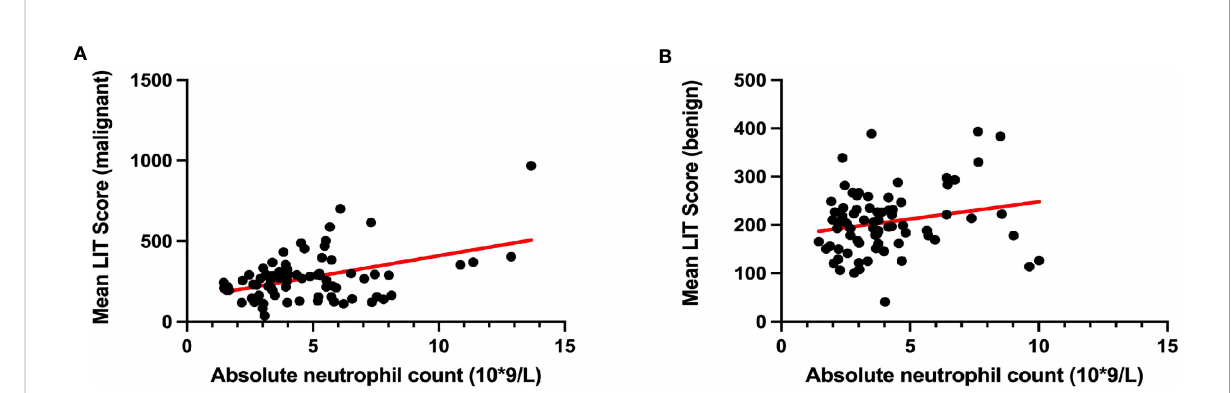
FIGURE 2 The correlation between patients ’ Leukocyte ImmunoTest (LIT) score and their absolute neutrophil count. (A) The correlation between LIT score and absolute neutrophil count in cancer group. (B) The correlation between LIT score and absolute neutrophil count in control group. Pearson ’ s correlation test indicated that mean LIT score and absolute neutrophil count were positively correlated in patients with malignant tumor ( A ; Pearson ’ s r = 0.4329 [0.2299, 0.5998], p-value < 0.0001), but not in patients with benign tumor ( B ; Pearson ’ s r = 0.2102 [ − 0.01917, 0.4186], p-value = 0.0722).